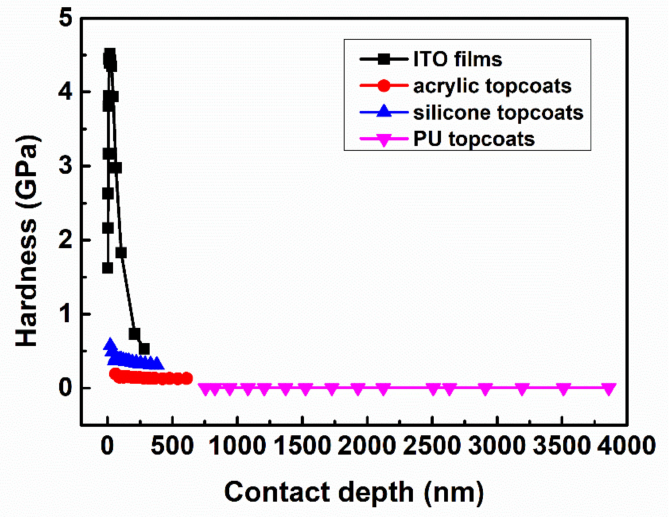
Figure 3. Hardness measurements of four kinds of specimen (uncovered ITO films, ITO films covered by acrylic-based, silicone and PU topcoats) at different indentation